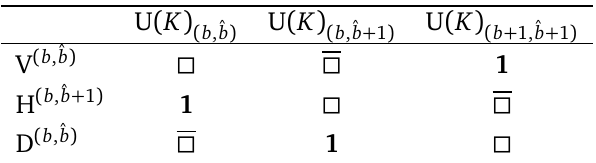
Table 1: The chiral multiplets for the toroidal quiver and their gauge-group repre-